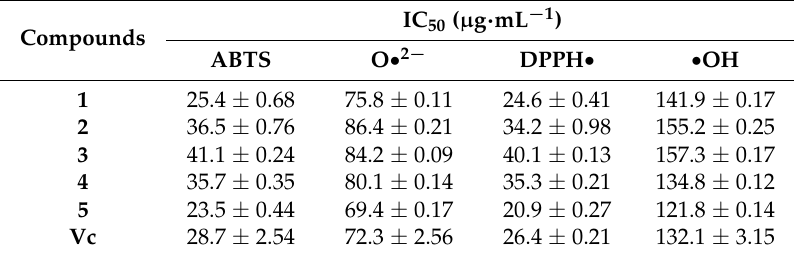
Table 2. Scavenging effects of flavonoids from P. ostii on radicals.